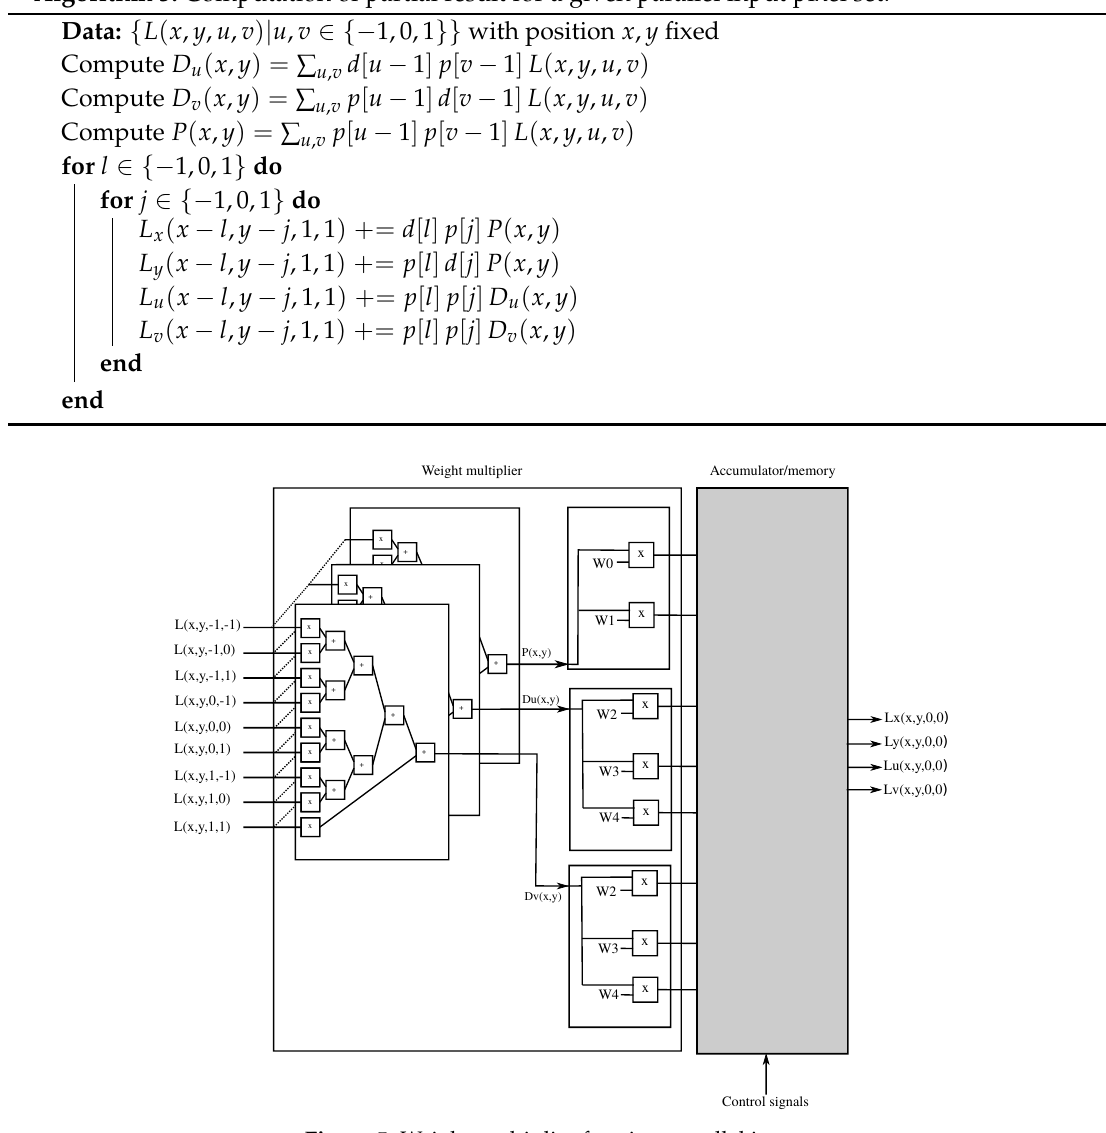
Figure 5. Weight multiplier for view parallel input. Table 2. Non-zero and positive distinct filter coefficients for parallel input.